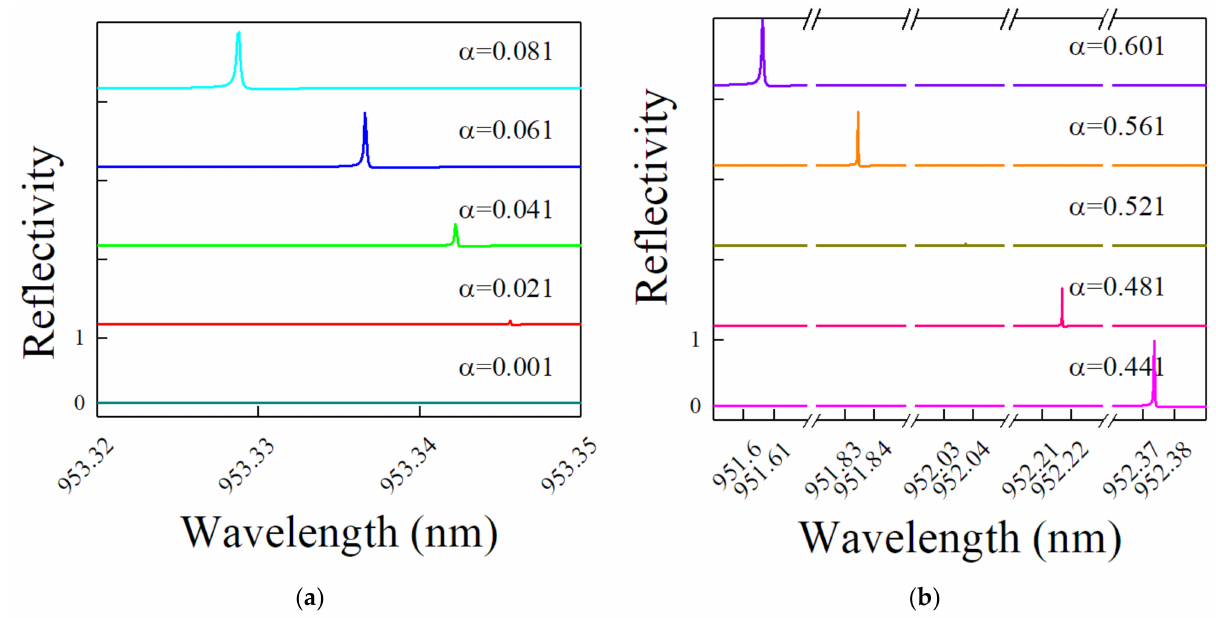
Figure 3. The reflection spectrum variation with the asymmetry parameter α near ( a ) region B and ( b ) region